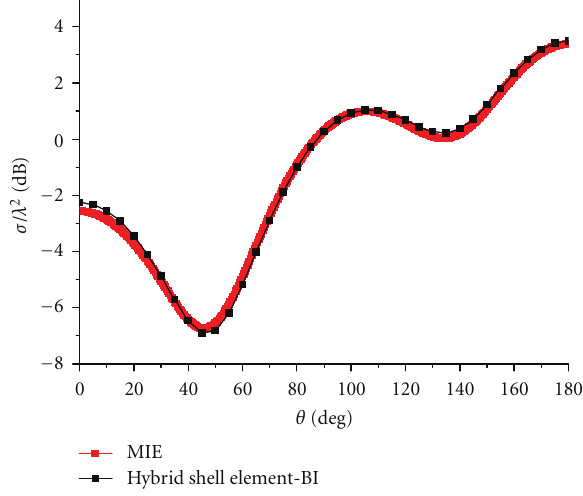
Figure 4: The bistatic RCS of the conducting sphere coated by magnetic material by the hybrid shell